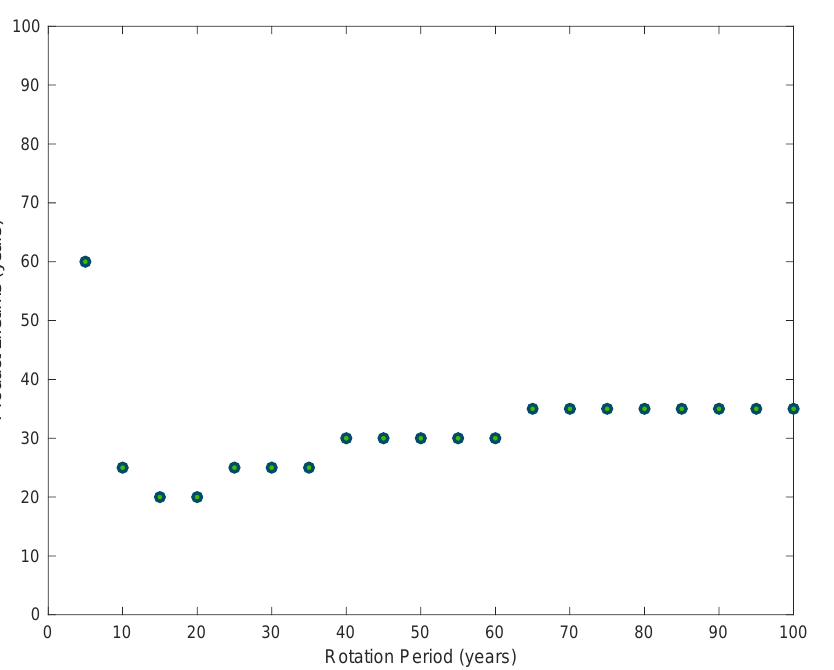
Figure 4. Product lifetime required for obtaining a negative GWP bio in terms of the biomass rotation period.